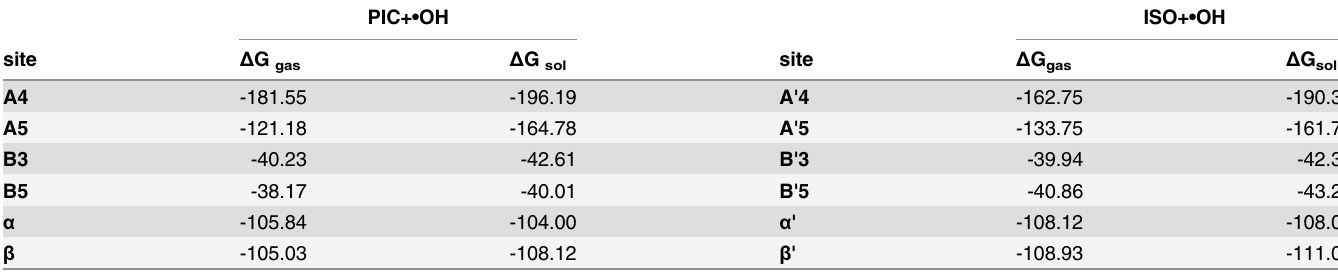
Table 1. The reaction Gibbs energies for reactions of PIC and ISO with (cid:129) OH in the gas phase and water (in kJ/mol).